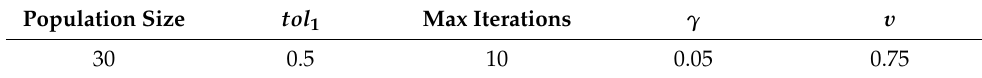
Table 2. Differential evolution parameters.